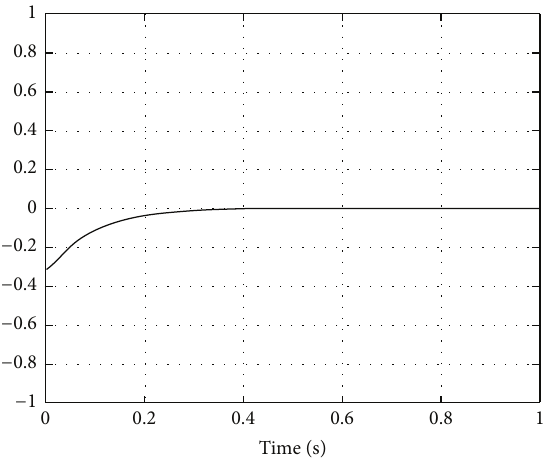
Figure 3: The output angular position 𝑥 3 (𝜃 2 ) of the two inverted